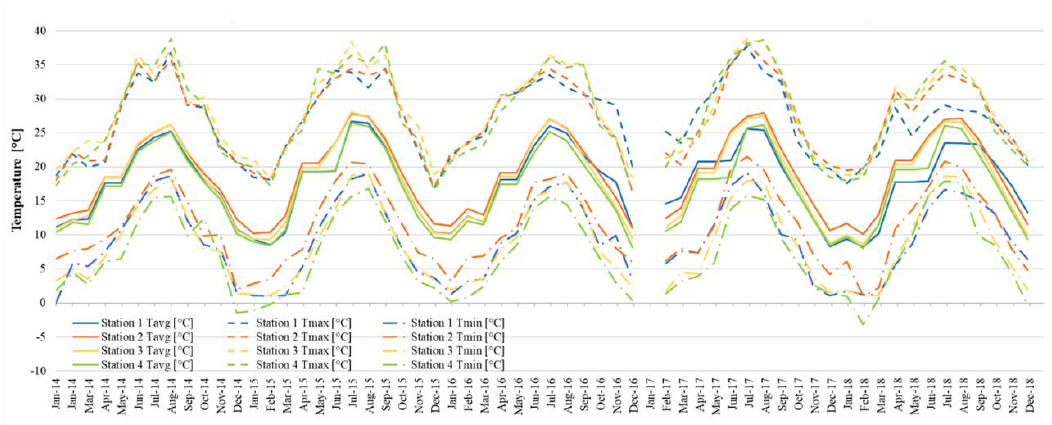
Figure 6. Monthly average temperatures, monthly maximum and minimum temperatures from 2014 to 2018.